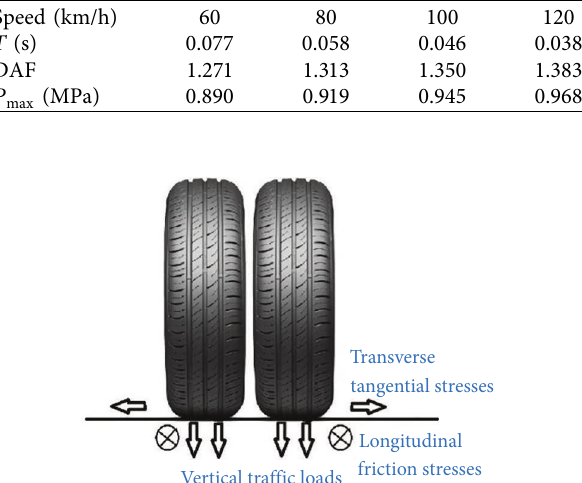
Figure 11: Contact stresses (vertical, transverse, and